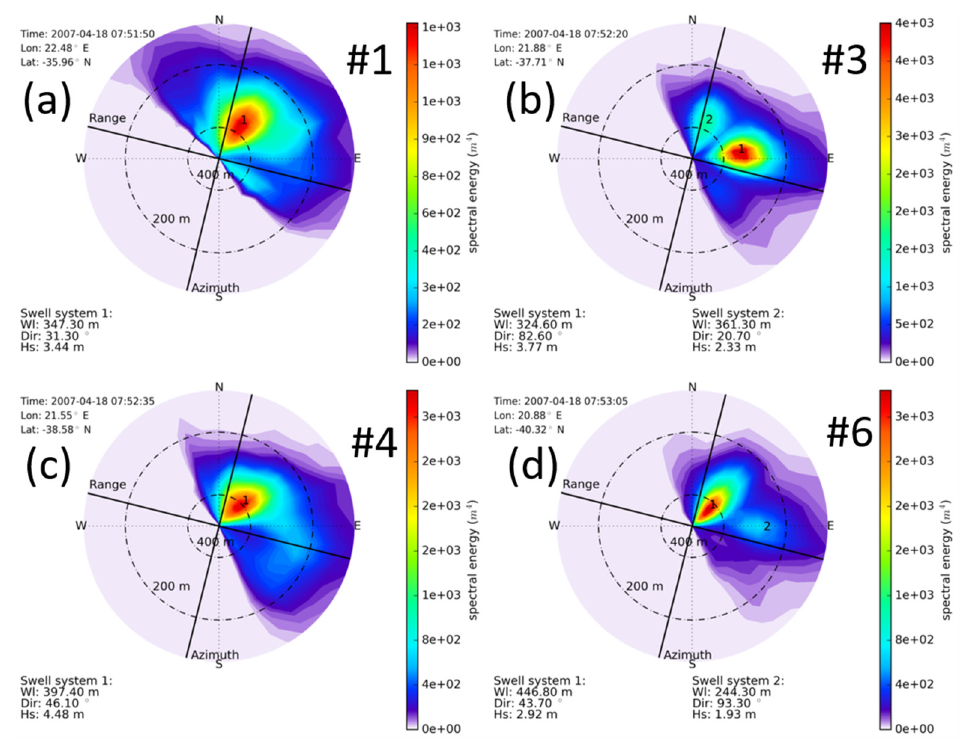
Figure 6. ( a – d ) Swell spectra from Envisat ASAR imagettes #1,3,4,6 in Figure 5.